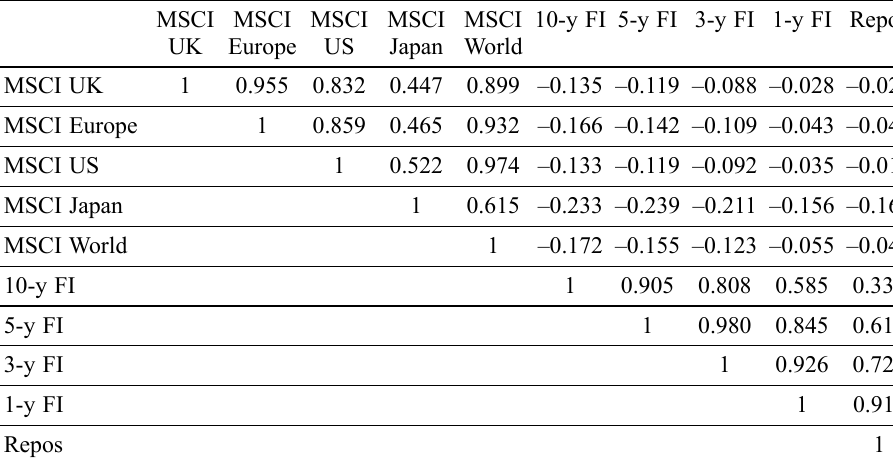
Table 2. Correlation